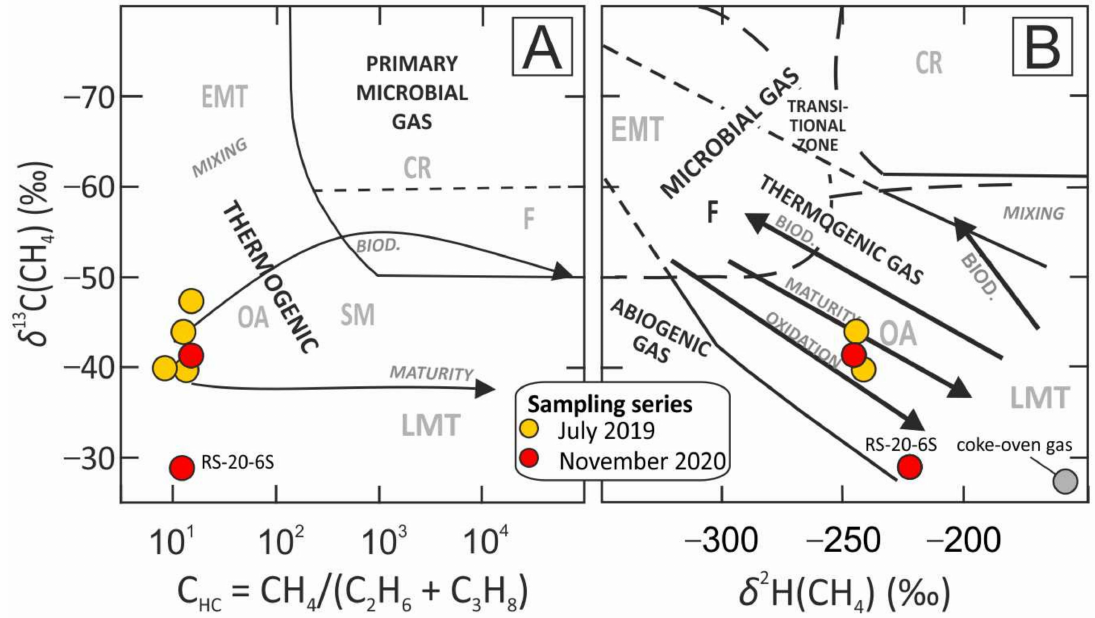
Figure 6. Stable carbon isotope composition of methane versus ( A ) hydrocarbon index (C HC ) and ( B ) stable hydrogen isotope composition of methane of analysed gases. Modified genetic fields and arrows directions of maturity and secondary processes after Milkov and Etiope [37]. CR, microbial CO 2 reduction; F, methyl-type fermentation; SM, secondary microbial; EMT, early mature thermogenic gas; OA, oil-associated thermogenic gas; LMT, late mature thermogenic gas; BIOD,